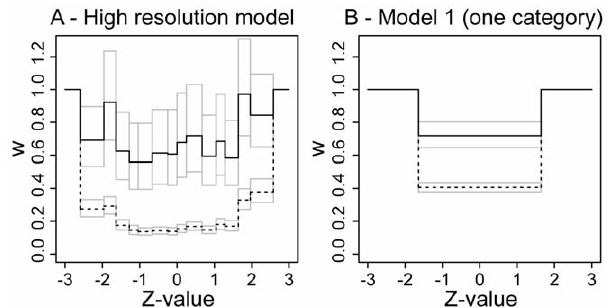
Figure 2. Results for the high-resolution models and the one category model (Model 1). Estimates for the high-resolution random-effects model are shown in solid lines, estimates for the fixed-effect model in dashed lines. Error bars show standard errors of the estimate. ( A ) High resolution model. For both the fixed-effect and random-effects model, the weights drop rapidly as |Z| decreases. At about |Z|=1.64 , the weights hit a bottom and remain relatively constant in the central intervals. This is what one would expect for publication bias: Non-significant results are subject to a similar bias, irrespective of the Z-value. ( B ) Model 1. In the random-effects model, bias in the mid interval is estimated as w (S) < 0.7 . Under the fixed-effect model, we estimate w (S) < 0.4 . The estimates for the bias in the fixed-effect model tend to be higher than in the random-effects model, because in the random-effects model, a high between-study variance offers an additional explanation for an excess of formally significant results.